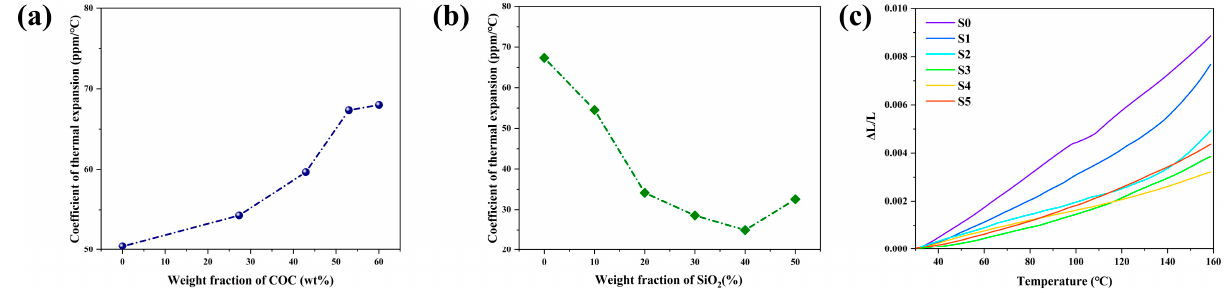
Figure 5. Influence of the content of COC ( a ) and SiO 2 ( b ) on the CTE in the temperature range of 25–150 °C; ( c ) dynamic mechanical curves of S0, S1, S2, S3, S4, S5 as a function of the temperature.